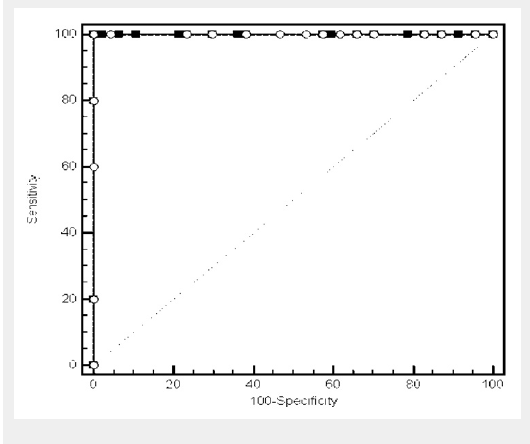
Receiver operating characteristic (ROC) curves for prediction of permanent hypoparathyroidism using intraoperative rapid PTH assay or standard PTH assay taken 24 hours after surgery. Both curves had an area under the curve (AUC) of 1.0 (SE = 0, 95% CI = 0.932 – 1.0, P < 0.001). The two curves were identical (P = 1.0). The optimal cutoff value was a PTH level < 12 pg/ml on the intraoperative PTH curve or < 15 pg/ml on the postoperative PTH curve. Both cutoff values had a sensitivity of 100% (95% CI = 47.8% – 100%), a specificity of 100% (95% CI = 92.5% – 100%), LR– of 0, PPV of 100% (95% CI = 47.8% – 100%), and NPV of